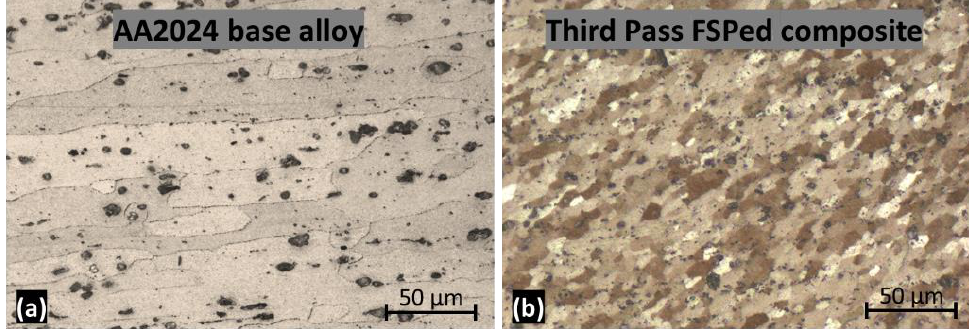
Coatings 2021 , 11 , x FOR PEER REVIEW Figure 6. Optical microstructure image of the as-received AA2024 alloy ( a ), and ( b ) the FSPed at the third pass.